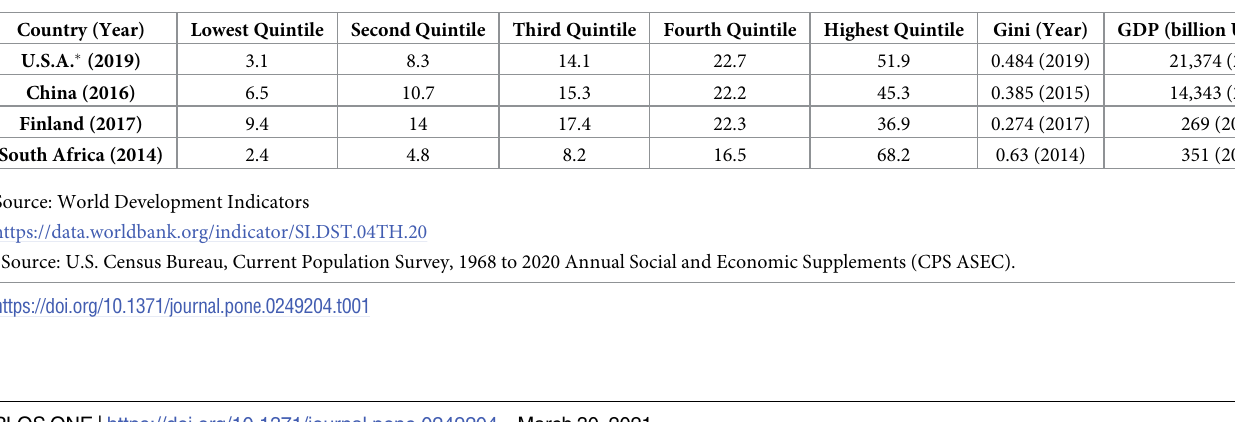
Table 1. Share of household income in four